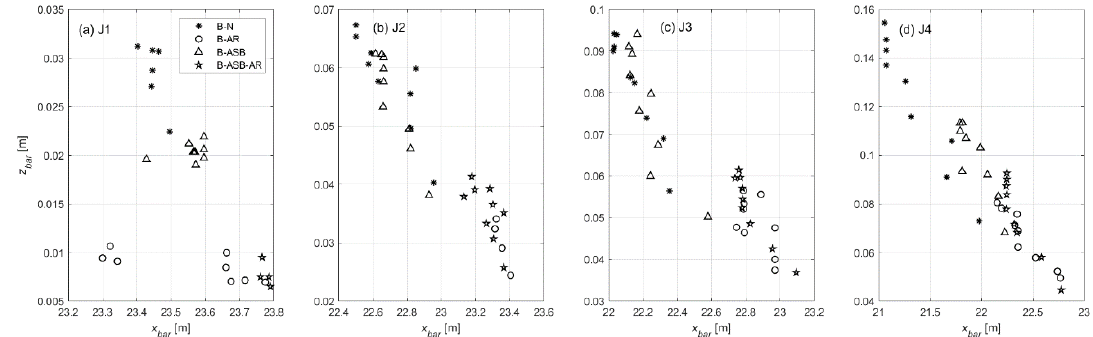
Figure 9. Comparison of the height and the location of the breaker bars under different incident waves ( a – d ). The beach states are classified as two extremes (i.e., fully dissipative and highly reflective states) and four intermediate states, i.e., longshore bar-trough (BT), rhythmic bar and beach (RB), transverse bar and rip (BR), and ridge-runnel or low tide terrace (LT). The surf-scaling parameter ε , Equation (17) [90], was originally used to distinguish the morphodynamic